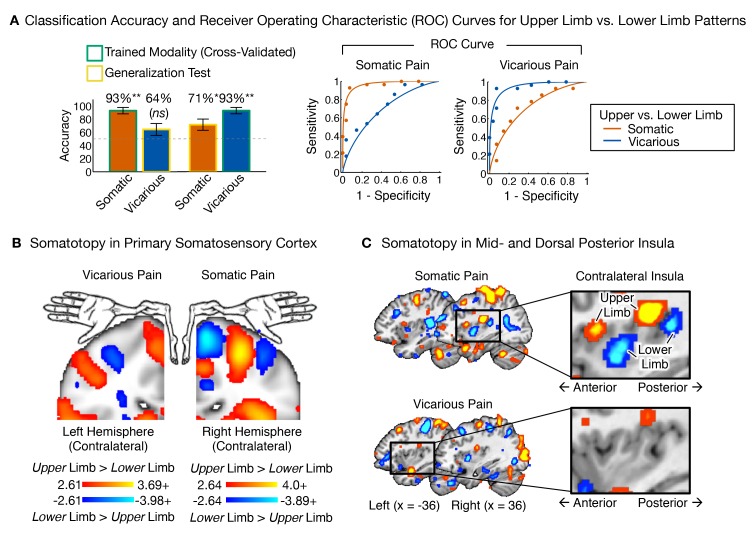
Upper limb versus lower limb multivariate patterns for somatic and vicarious pain.(A) Accuracy statistics for upper limb versus lower limb weight maps for somatic and vicarious pain; Receiver Operating Characteristic (ROC) curves for two-choice forced alternative tests for upper versus lower limb sites; (B) Support Vector Machine (SVM) derived pattern for upper limb versus lower limb sites for somatic and vicarious pain, bootstrap thresholded at FDR q<0.05 for display purposes, showing somatotopy for these sites in the primary somatosensory cortex (schematic of homunculus shown for reference); (C) SVM derived pattern for upper limb versus lower limb sites for somatic and vicarious pain, bootstrap thresholded at FDR q<0.05 for display purposes, showing somatotopy for these sites in the mid- and dorsal-posterior insular cortex (warm colors indicate upper limb regions and cool colors indicate lower limb sites).